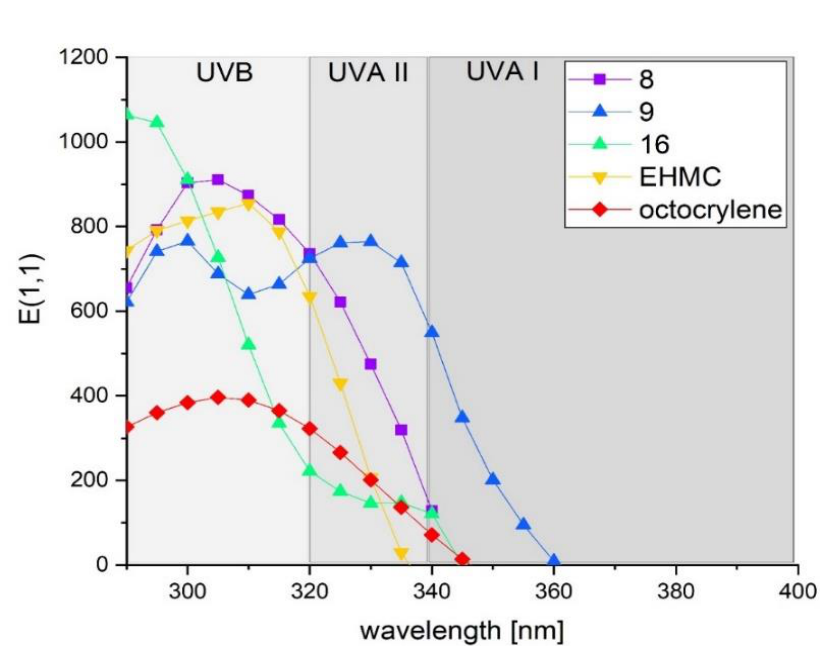
Figure 4. UV-absorption spectra of tested compounds and reference UV filters in chloroform solutions. E(1,1)—extinction at 1% concentration and 1 cm optical pathlength.